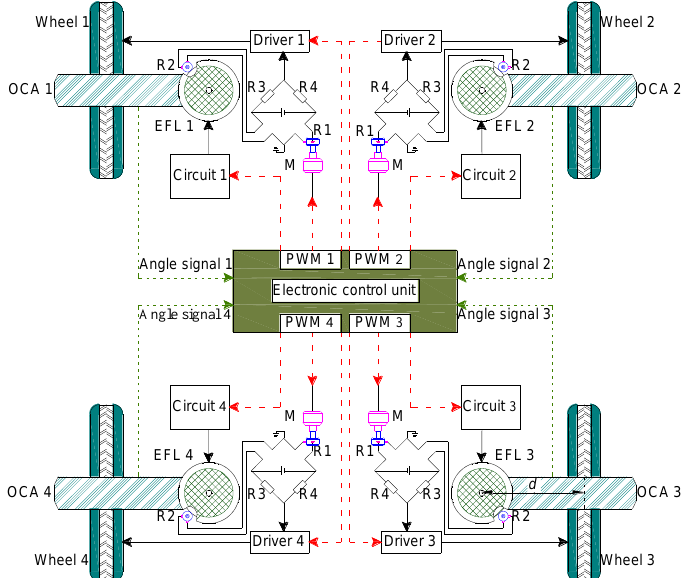
Figure 1. Overall flexible chassis structure and control system. Wheels 1, 2, 3, and 4 respectively denote left front, right front, left rear, and right rear wheel. R1, R2, R3, and R4 denote the four arms of the steering tracking bridge circuit. EFL, electromagnetic friction lock; OCA, off-center arm; M, driving motor of the bridge circuit arm; PWM, Pulse Width Modulation; d , off-center distance. Each OSM consists of an electromagnetic friction lock (FBD-050, Taiwan Kaide, Taiwan), an off- center steering shaft, an off-center arm, a suspension and an in-wheel motor (WX-WS4846, Fujitec, Tianjin, China. A bridge circuit made of four arms identified as R1, R2, R3, and R4 achieves steering